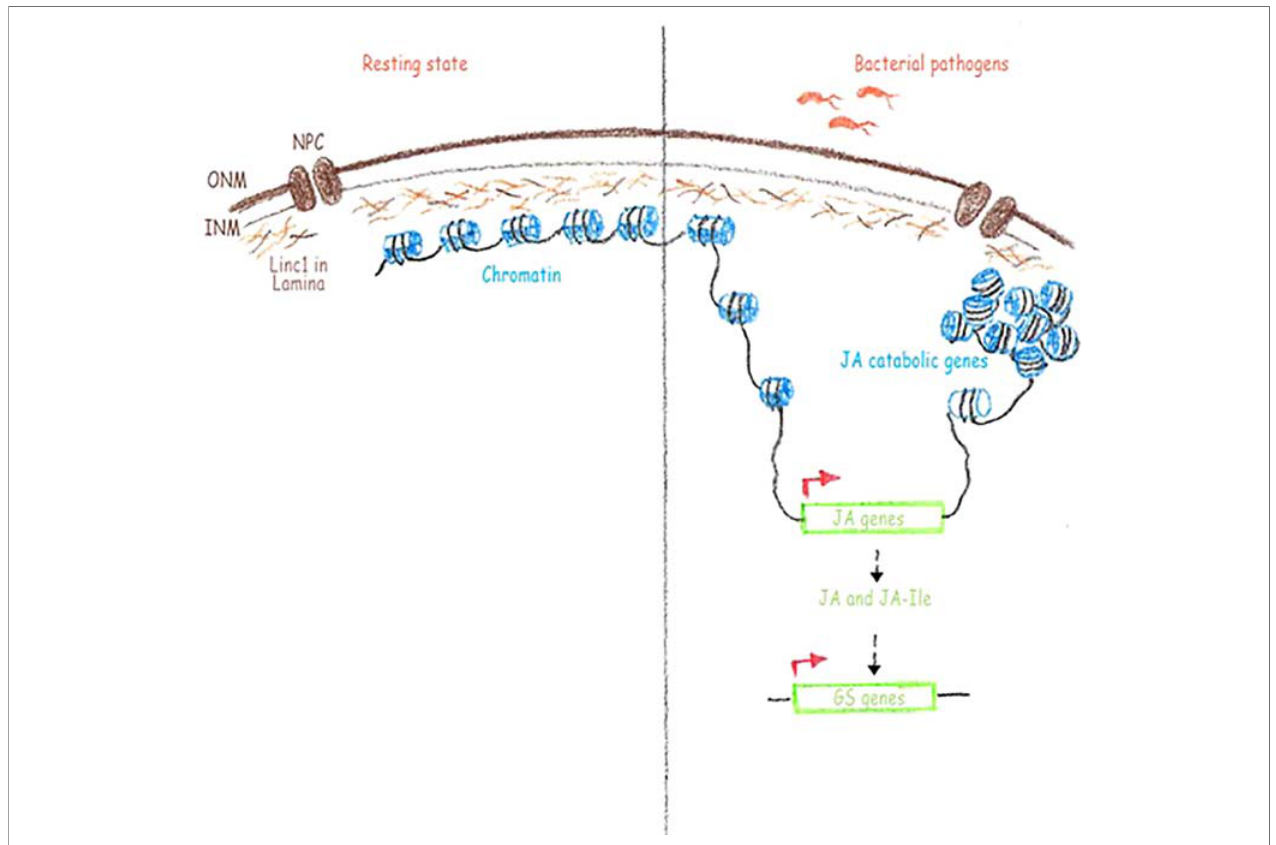
FIGURE 6 | Hypothetical working model for the role of LINC1 in plant immunity. Linc1 is present in nuclear lamina and acts as a sort of scaffold to hold the chromatin. When necessary, such as during a pathogen infection, Linc1 facilitates the open conformation of the genes required for defense, such as the JA biosynthetic and signaling genes and closed conformation of certain other genes such as the JA catabolic genes resulting the accumulation of JA and JA-Ile. The increased amounts of JA and JA-Ile inturn switch on the expression of glucosinolate genes. ONM, outer nuclear membrane; INM, inner nuclear membrane; NPC, nuclear pore complex; JA, jasmonic acid; JA-Ile, jasmonic acid- isoleucine; Gs, glucosinate